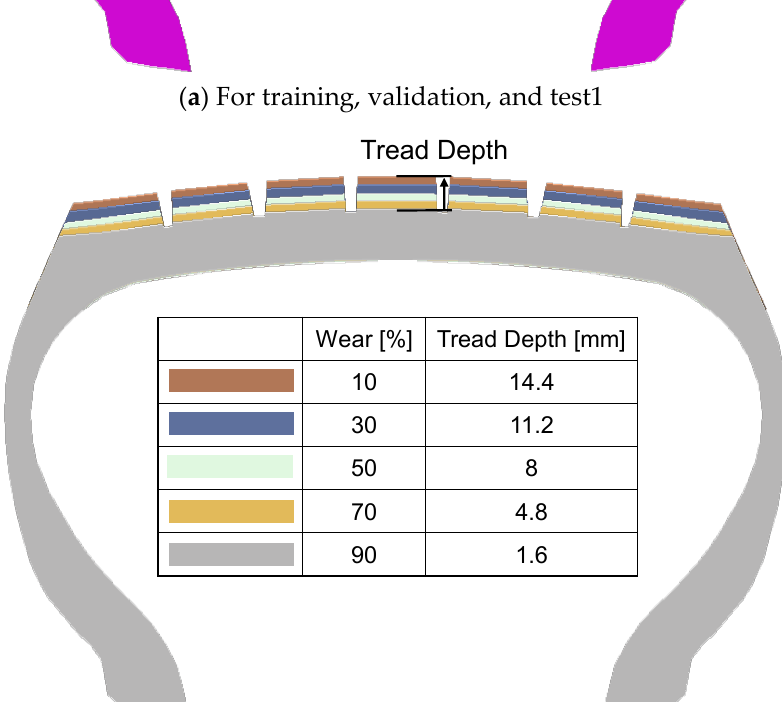
Figure 5. Set of tread depth conditions for rolling simulations.